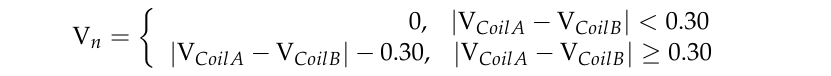
Figure 6. ( A ) Coils in series followed by rectification. ( B ) Coils in series after rectification. ( C ) Coils in parallel followed by rectification. ( D ) Coils in parallel after rectification .